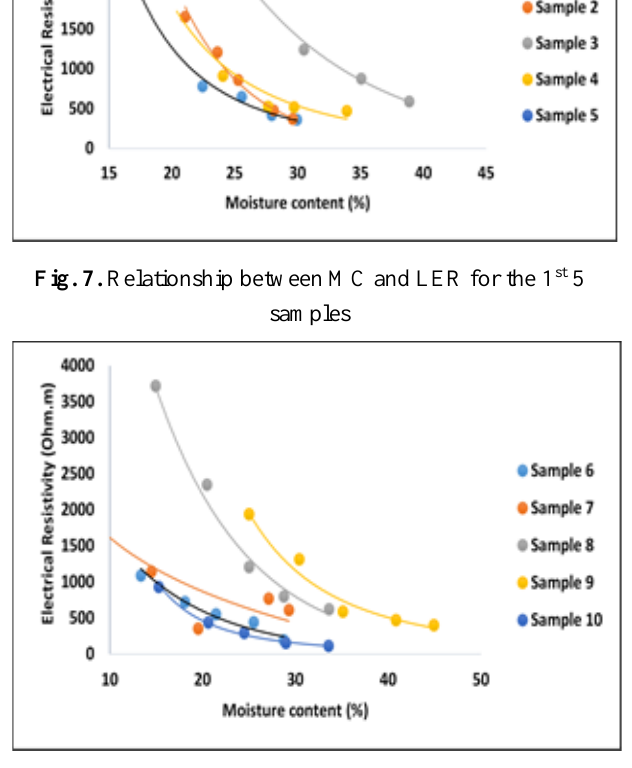
Fig. 8. Relationship between MC and LER for samples from